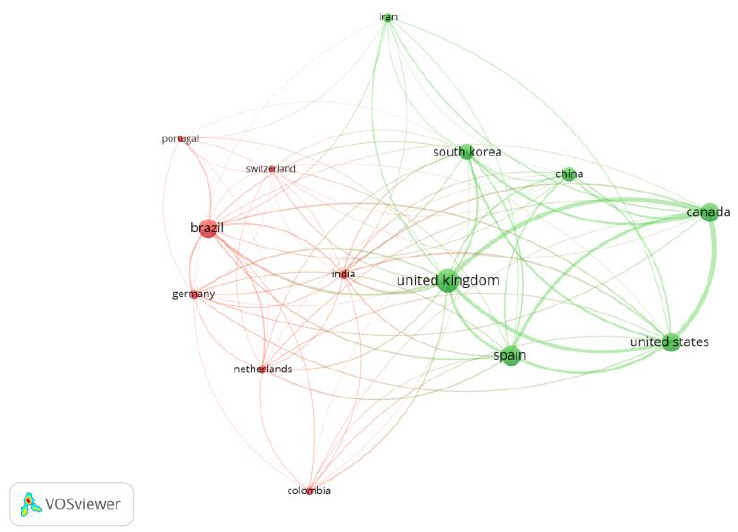
Figure 9. Visualization of the country collaboration network for studies on clavulanic acid production by Streptomyces clavuligerus . Note: Countries contributing a minimum number of five documents and citations.